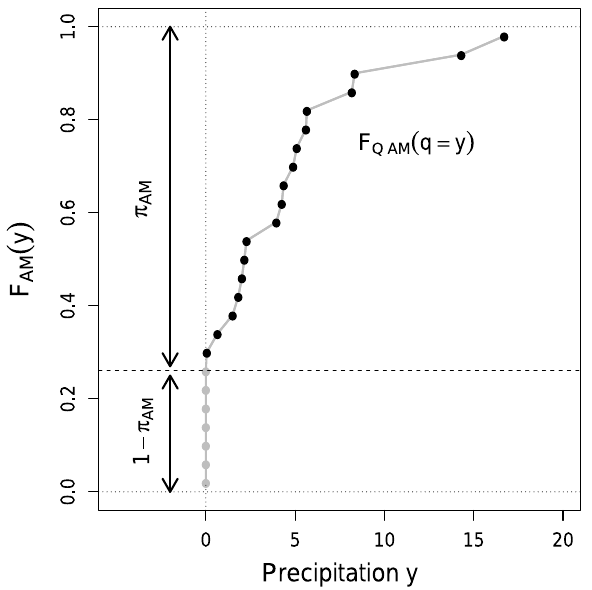
Figure 1. Cumulative distribution function (cdf) of the precipitation amount for a given prediction day (in gray) at a given grid cell. For illustration, the prediction here corresponds to the empirical cdf achieved with the analog model (AM) mentioned in Sect. 3.3. The contribution of the precipitation amount F Q, AM cdf to the overall cdf is highlighted in black (cf. Eq.